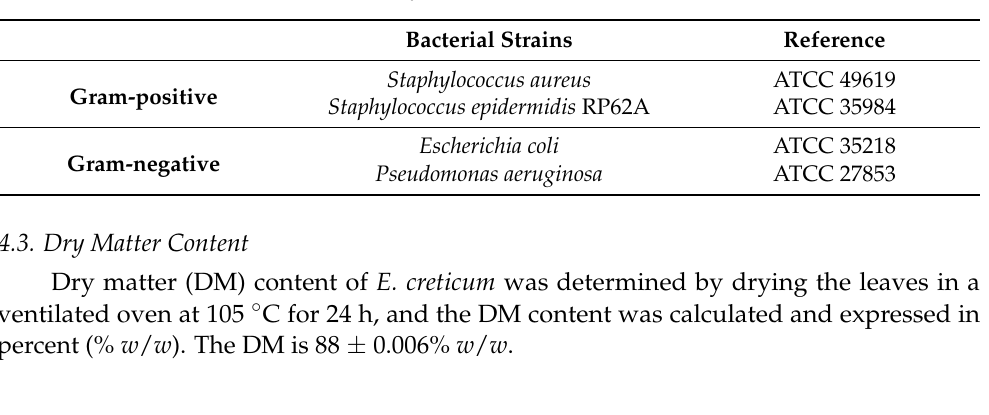
Table 6. Bacterial strains used in this